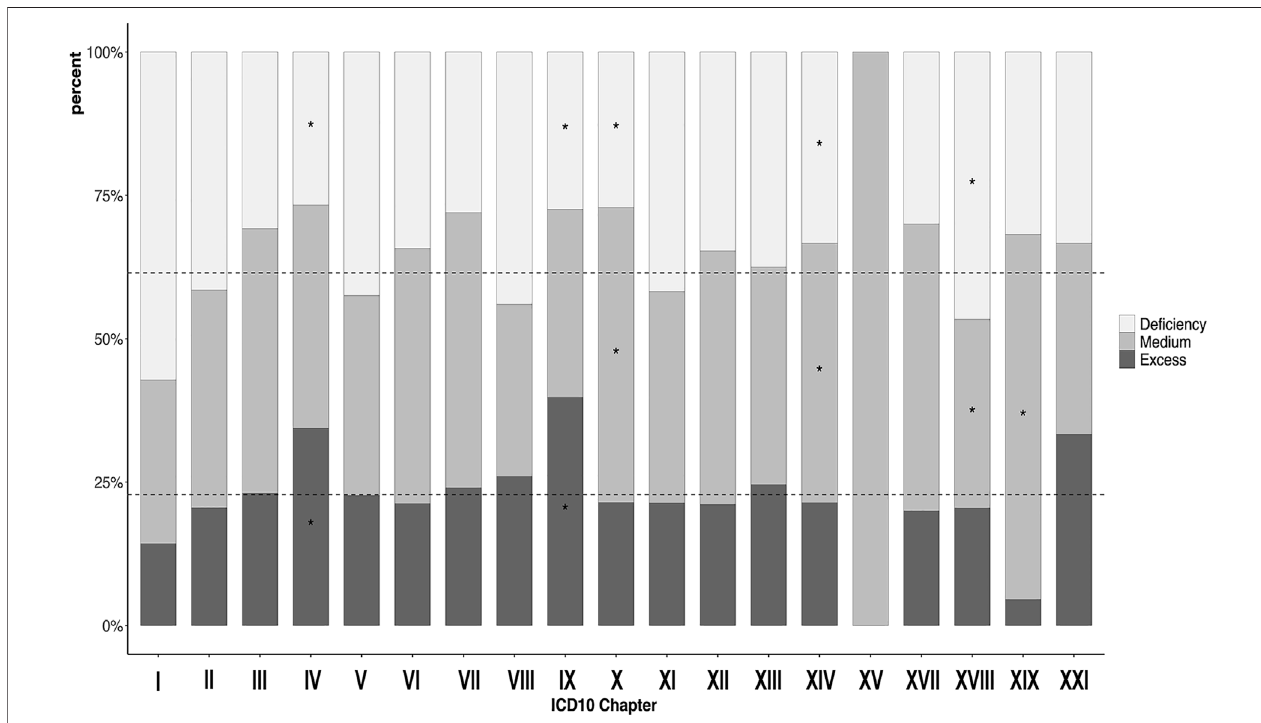
FIGURE 1 | Proportion of participants with de fi ciency-excess in each the 10th version of the International Classi fi cation of Diseases chapters. * p < 0.05 ICD (cid:1) International Classi fi cation of Diseases. I: Infection (35); II: Neoplasm (200); III: Hemotology/Immunology (13); IV: Endocrine/metabolism (90); V: Psychiatry (106); VI: Neurology (146); VII: Ophthalmology (25); VIII:Audiology (50); IX: Circulatology (113); X: Pulmonology (70); XI: Gastroenterology (206); XII: Dermatology (147); XIII: Musculoskeletal (224); XIV: Genitourology (243); XV: Obstetrics (3); XVII: Congenital (10); XVIII: Symptoms/signs (474); XIX: Injury/poisoning (22); XXI: Health state